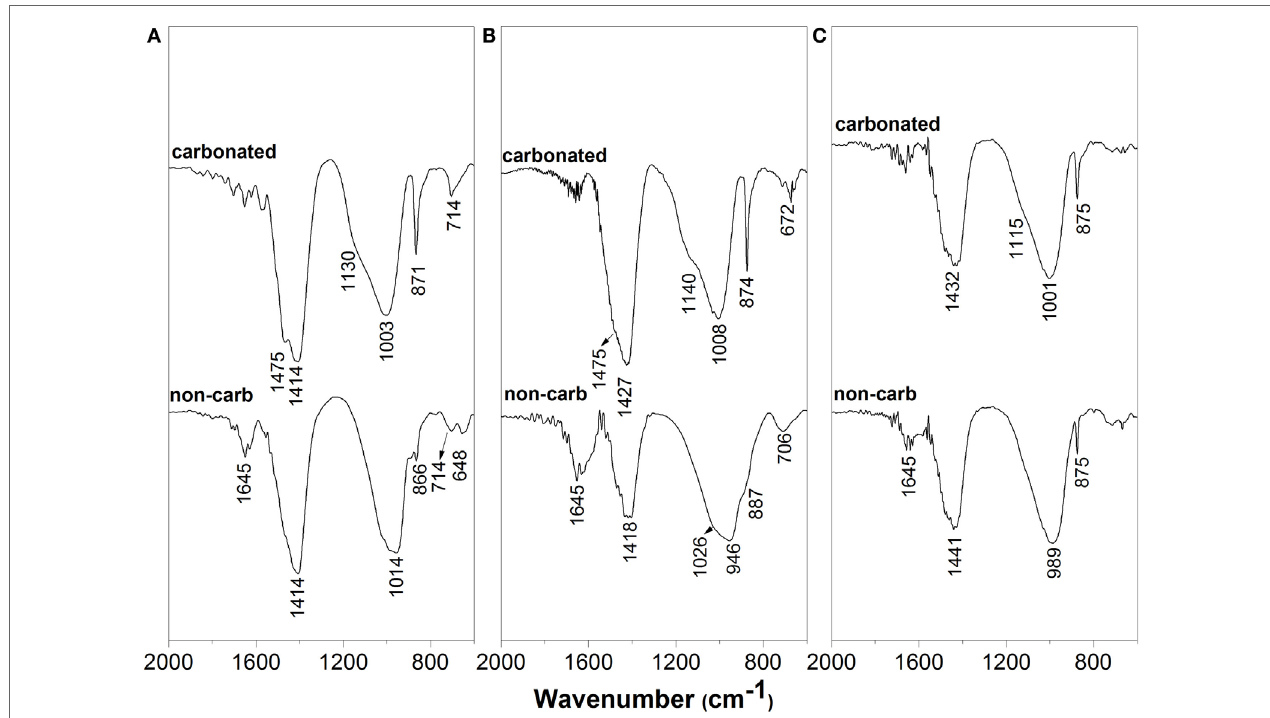
FigUre 3 | FTir spectra of non-carbonated and accelerated-carbonated alkali-silicate-activated slag/metakaolin pastes with gbFs/(gbFs + MK) ratios of (a) 1.0, (b) 0.9, and (c) 0.8